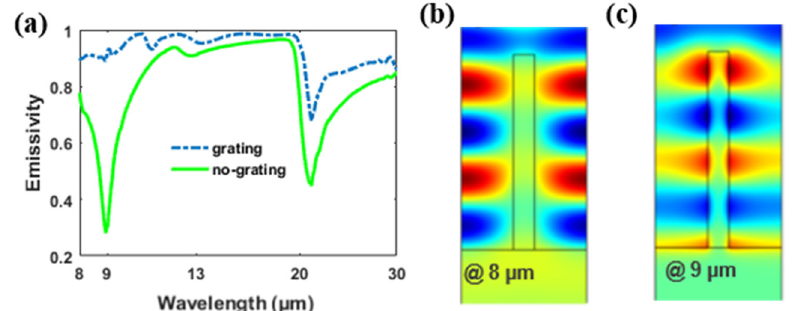
Figure 7. ( a )Absorption/emissivity for the proposed structure with or without the grating at 8–30 µ m. ( b , c ) Spatial distribution of magnetic field ( H y ) at different wavelengths in the grating structure. Red and blue represent the maximum and minimum magnitudes, respectively.